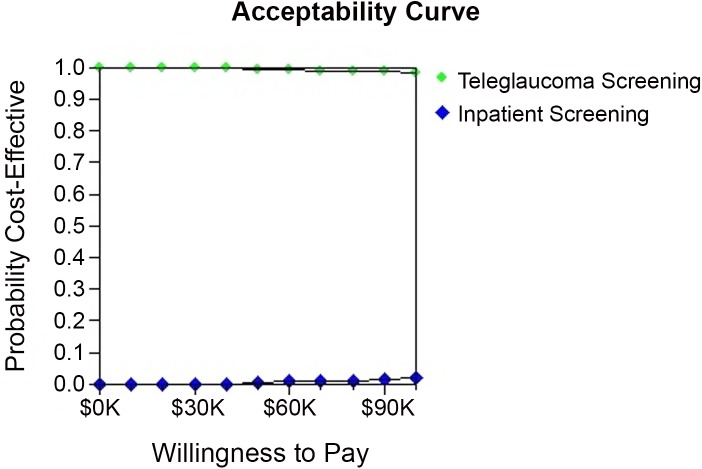
Acceptability Curve.